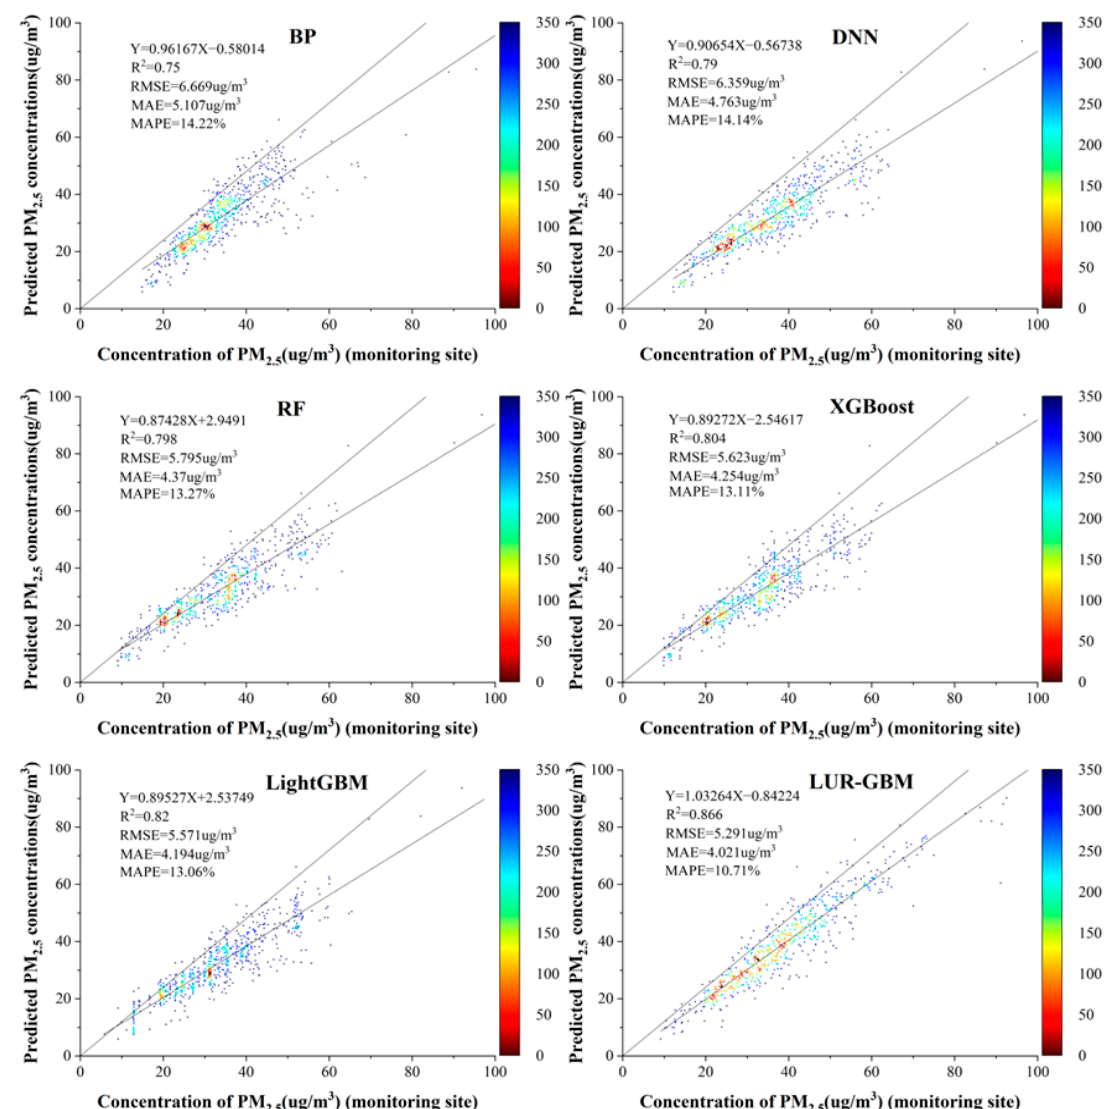
Figure 4. Scatter density plots of annual mean concentrations for the six models. Figure 5 shows a scatter density plot of the PM 2.5 concentrations estimated by the LUR-GBM model on a seasonal scale and fitted to the PM 2.5 concentrations measured at ground-based monitoring stations. A ten-fold cross-validation based on samples showed that R 2 (0.98) was highest in autumn. The highest RMSE (12.54 µ g/m 3 ) in spring and MAE (7.61 µ g/m 3 ) in winter were the seasons where the higher correlation between surface temperature and PM 2.5 contributed to the difference in R 2 . In contrast, the lowest R 2 (0.91) and the lowest RMSE (4.34 µ g/m 3 ) and MAE (3.01 µ g/m 3 ) were recorded in summer. The lower estimation error in summer was due to the lower ground level PM 2.5 mass concentration due to frequent rainfall and the higher estimation accuracy. Overall, the LUR-GBM model performed well on seasonal scales and was able to predict the distribution of PM 2.5 mass concentrations on seasonal scales. To test the accuracy of the LUR ‐ GBM model simulation, a linear correlation analysis was performed between the simulated PM 2.5 model values at